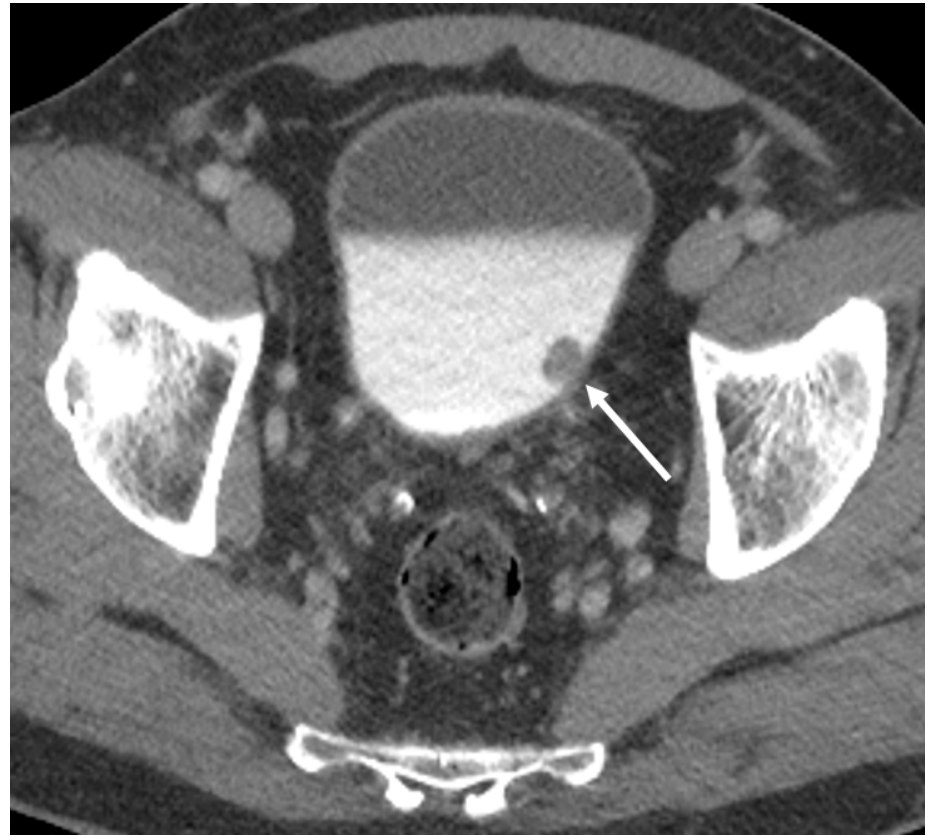
Figure 1. Axial CT images from the excretory phase of a CT urogram performed for hematuria demonstrating a polypoid filling defect arising near the left ureteral orifice (arrow), highly suspicious for bladder cancer.